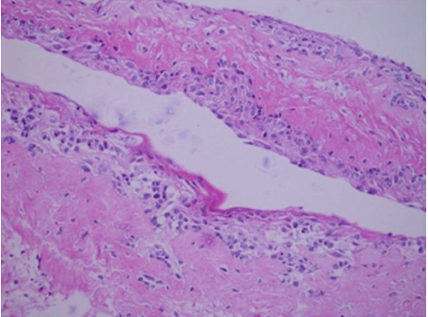
Figure 3: Histopathology of the cyst: cystic structure lined with